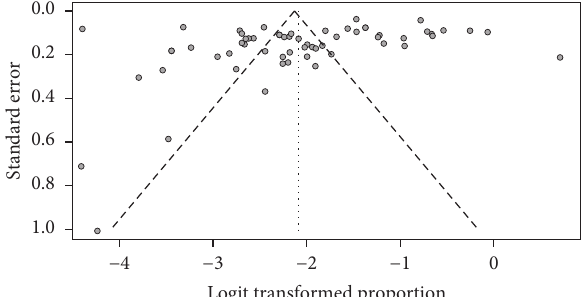
Figure 6: Funnel plot depicting publication bias of included